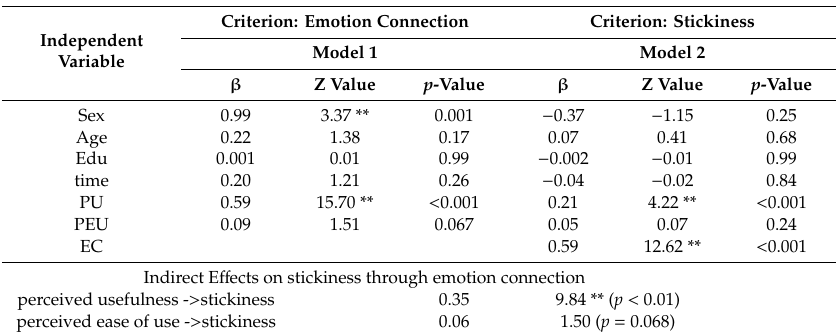
Table 2. Mediation analysis (log likelihood = -7971.85, estimation method =